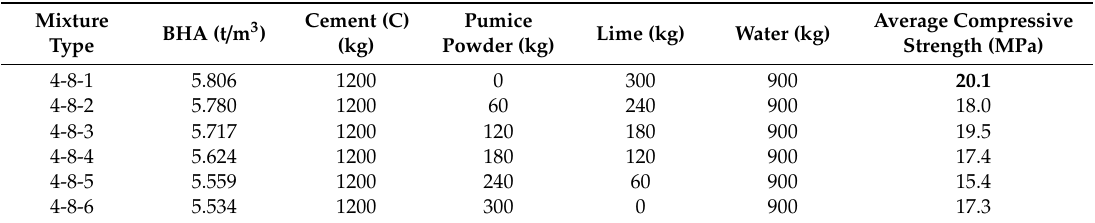
Table 32. Type-4-8 mixture quantity, weight per unit of volume and compression test